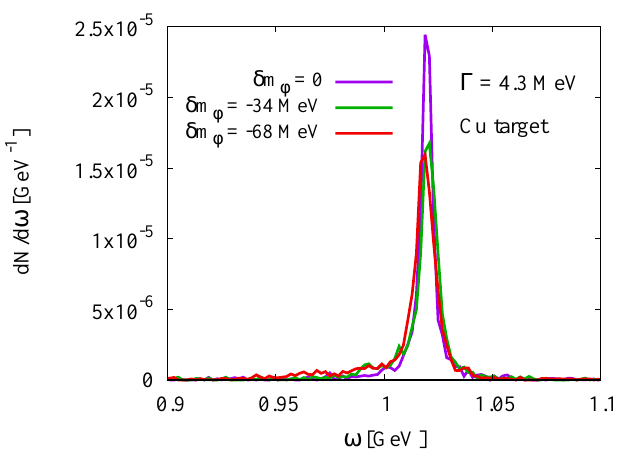
Figure 2. The ϕ meson contribution to the dilepton spectrum, obtained in simulations of 12 GeV pCu reactions for scenarios of di ff erent negative mass shift magnitudes for the ϕ meson at finite